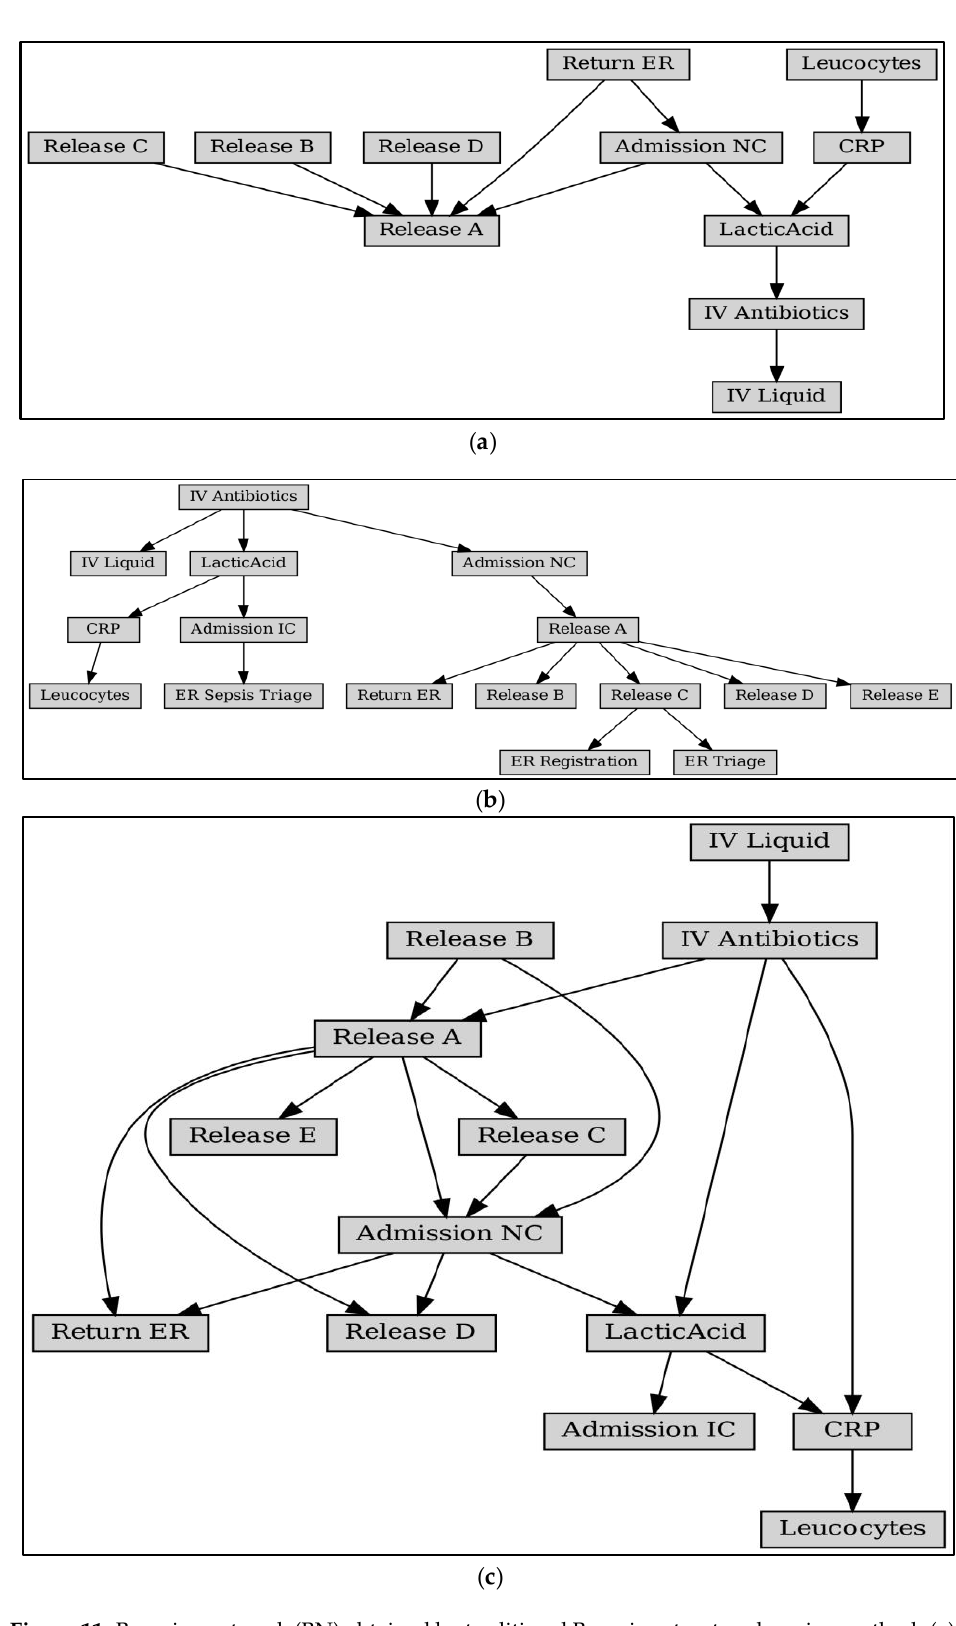
Figure 10. Process-based Bayesian Network for Sepsis.